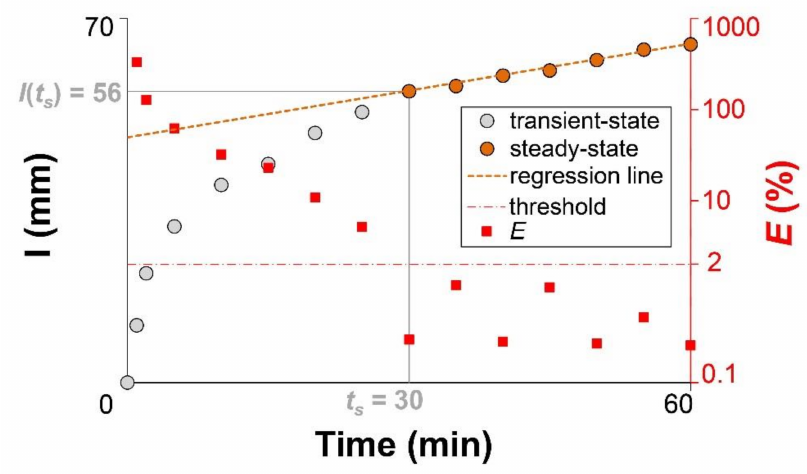
Figure 2. Procedure for estimating equilibration time, t s (min), and infiltrated depth at the equilibration time, I ( t s ) (mm), from cumulative infiltrations. Case of an infiltration run carried out at the burnt site in